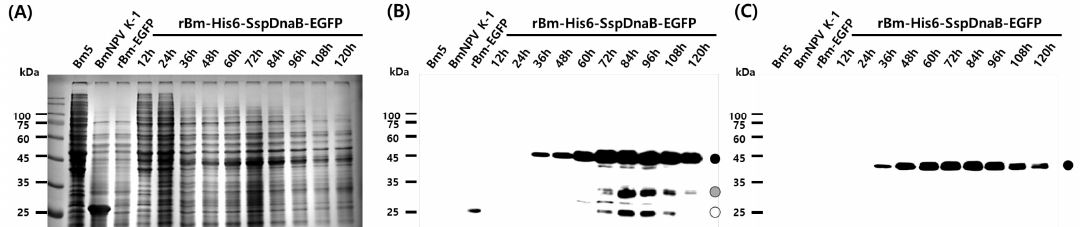
Figure 2. Time course analysis of recombinant enhanced green fluorescent protein (EGFP) fused with the Ssp DnaB mini-intein. Bombyx mori 5 (Bm5) cells were infected with 5 multiplicities of infection (MOI) of each virus and harvested from 12 to 120 hours post-infection (h.p.i) at intervals of 12 h. ( A ) Protein samples were analyzed by 12% SDS-PAGE ( B ) and Western blot analysis with an GFP monoclonal antibody ( C ) and His tag monoclonal antibody. Control samples by wild-type BmNPV-K1 and rBm-EGFP were prepared at 72 h.p.i. The black circle represents fusion-expressed EGFP with His6 and the Ssp DnaB mini-intein. The opened circle represents degraded fusion proteins. The gray circle represents EGFP.